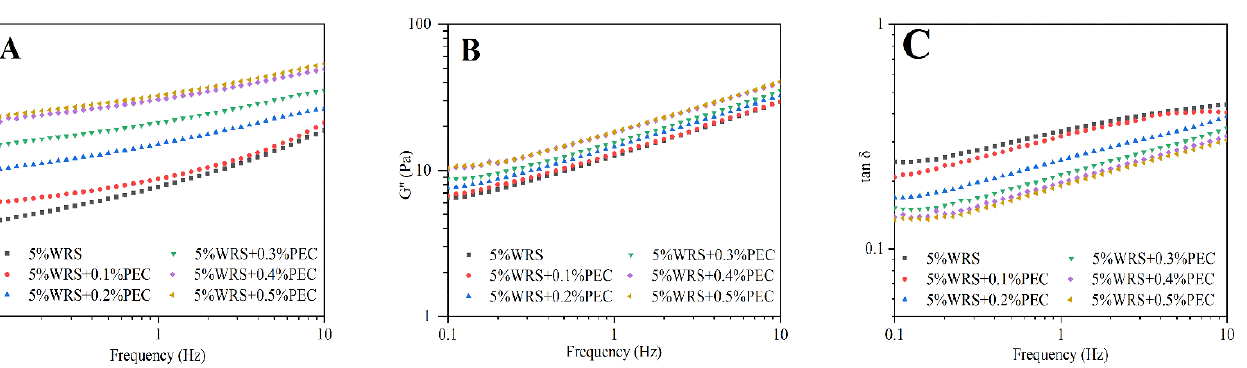
Figure 3. Variation of G ’ ( A ), G ” ( B ), and tan δ ( C ) with frequency for the WRS and the WRS–PEC mixtures.